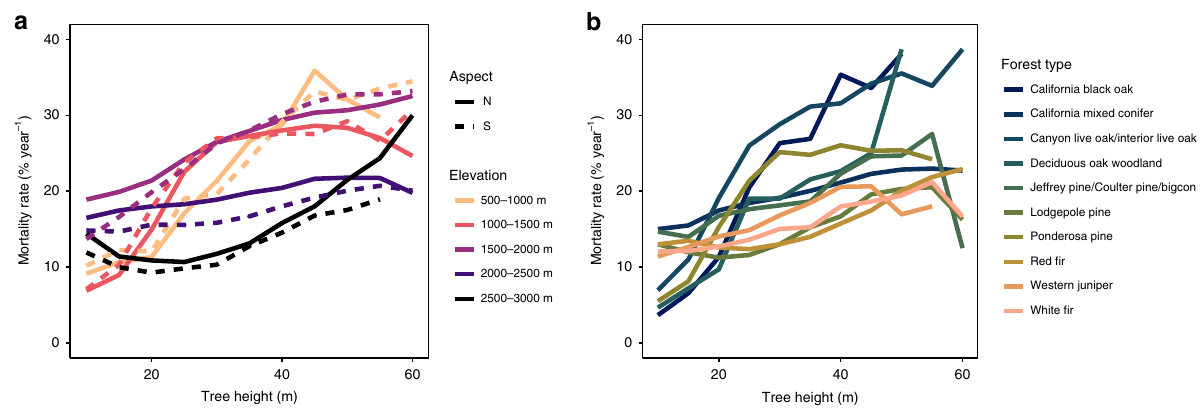
Fig. 1 Consistent trends in mortality rate and tree height. Mortality rate continuously increases with height across all a topographic positions (2 aspects × 5 elevation bins) and b forest types in the study area. If broad shifts in canopy species are the primary cause of different mortality rates, we would expect to see disparate trends in mortality rate with increasing tree height in different forest types.